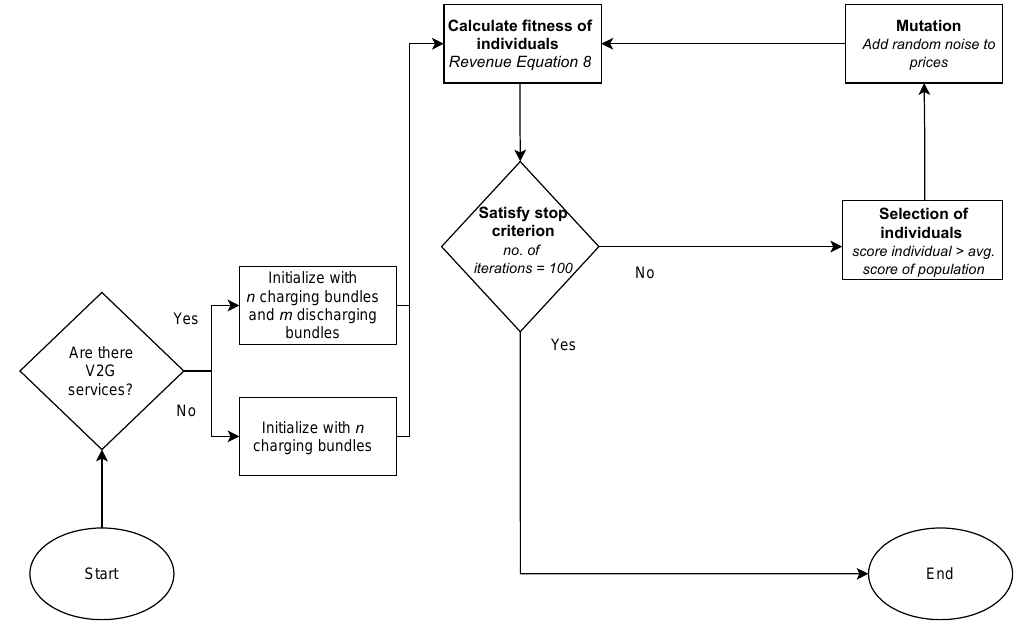
Figure 5. Genetic algorithm solution for price optimization.